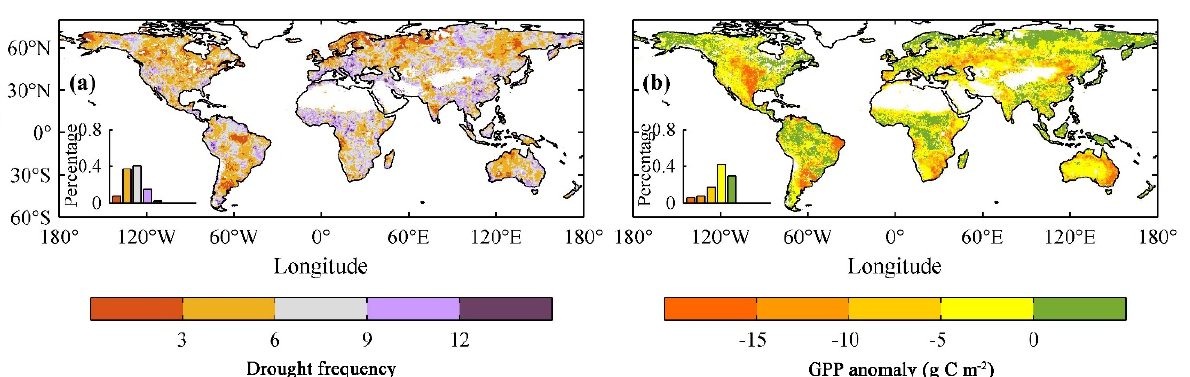
Figure 1. The dynamics trend and spatial distribution of the annual ensemble mean light-use efficiency (LUE) model gross primary productivities (GPPs) from 1982 to 2015. ( a ) Linear trend of annual ensemble mean LUE model GPPs. The shaded areas denote one standard deviation of each corresponding ensemble. ( b ) Spatial distribution of the linear change rate of GPP during 1982–2015. Only statistically significant trends ( p < 0.05) are shown in this figure. The inset shows the corresponding values’ frequency distribution.